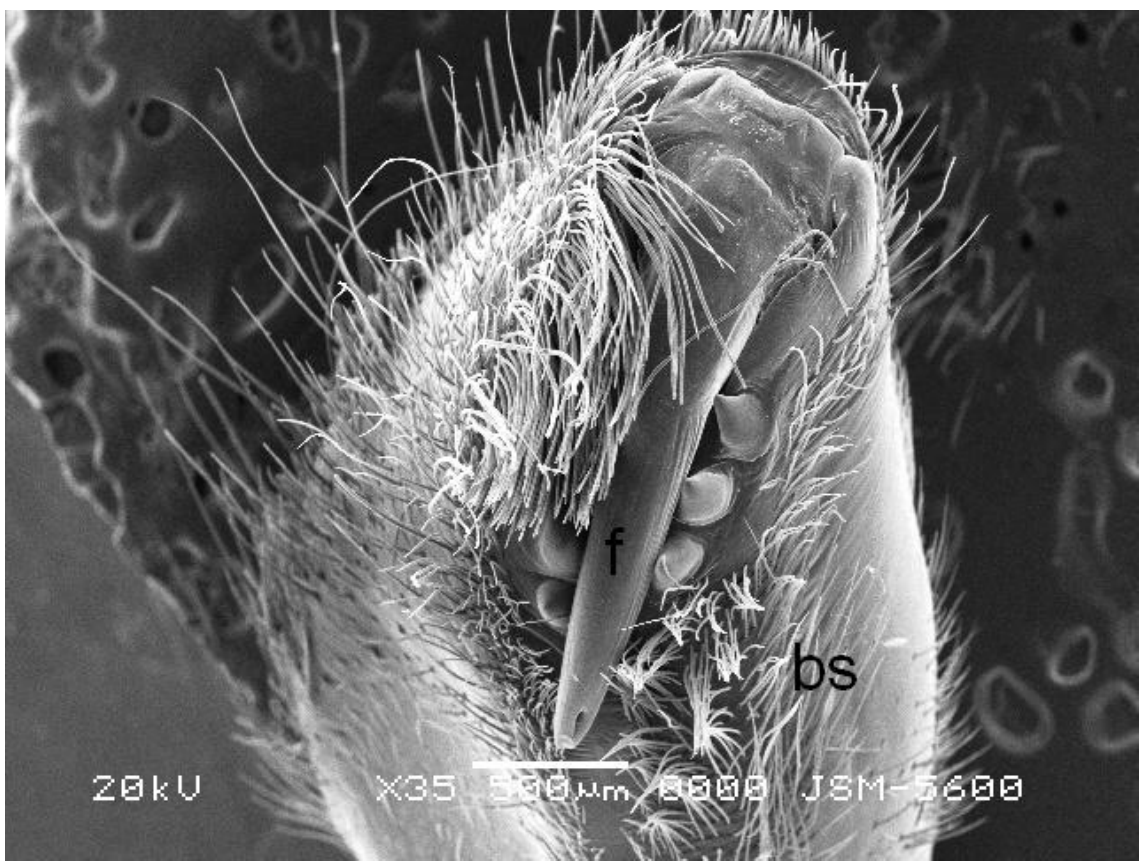
Figure 2. Chelicera of L. singoriensi s, the fang (f) and basal segment (bs). The basal segment is covered by dense